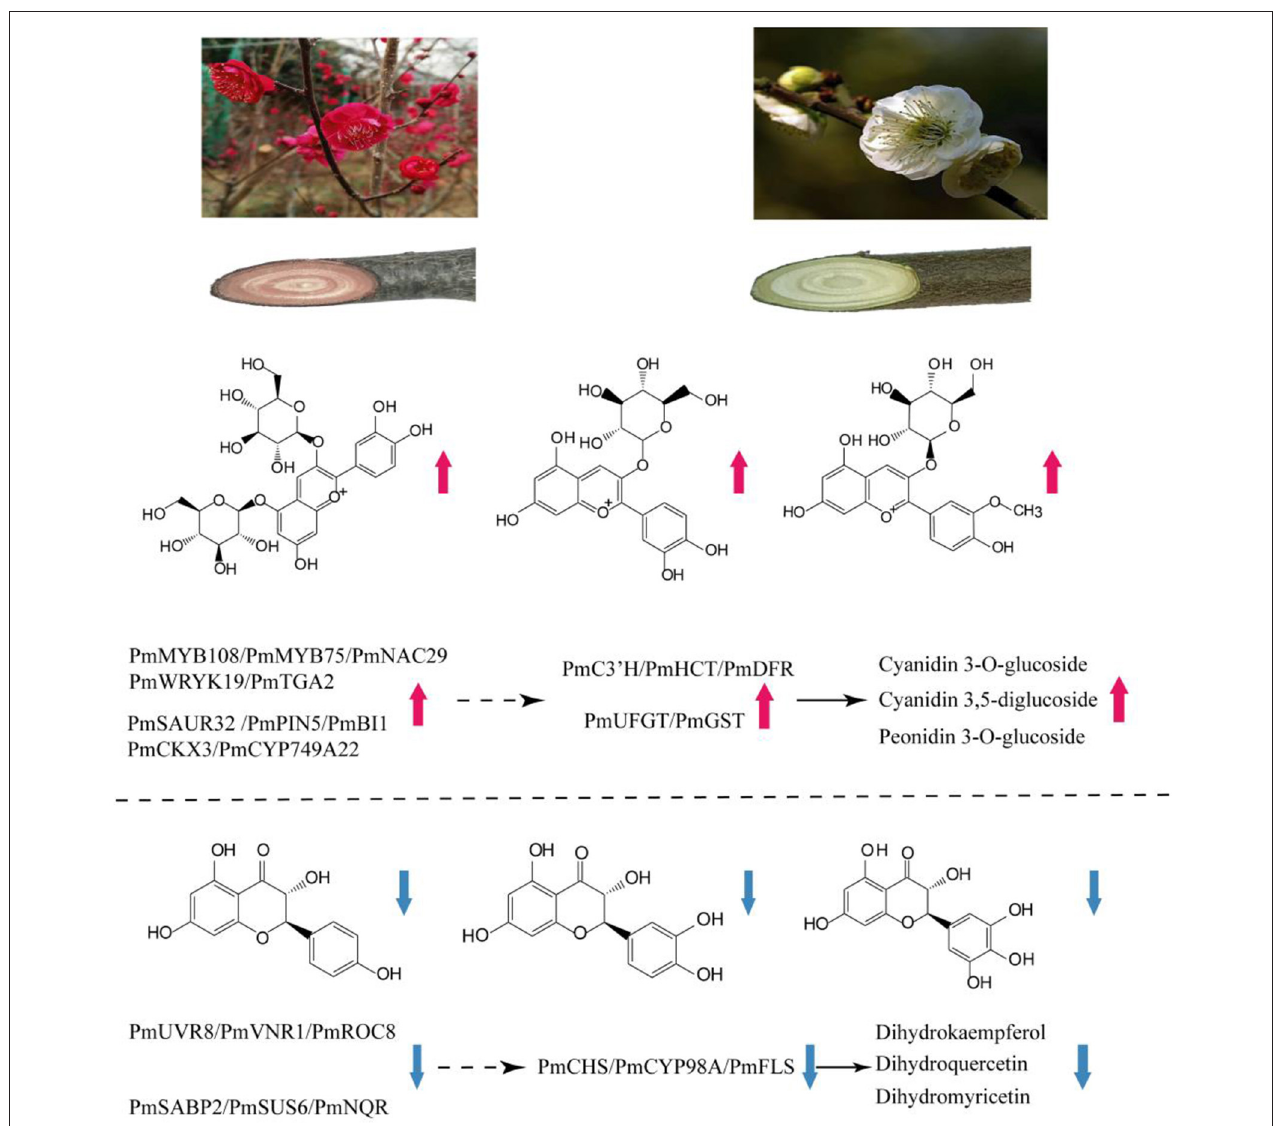
FIGURE 8 | Summary of transcription-level regulation of the red stem formation in P. mume. Transcripts and metabolites show obvious differences in WYY and FLE. Total anthocyanins content and expression of C3’H, HCT, DFR, UFGT, GST genes are increased, resulting in preferential anthocyanin pathway in WYY. Moreover,